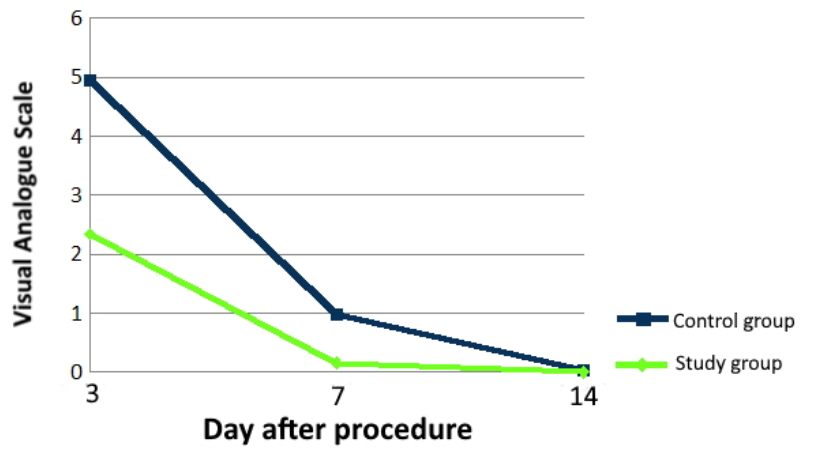
Figure 3. Time-dependent variability of pain intensity in the control and study groups.